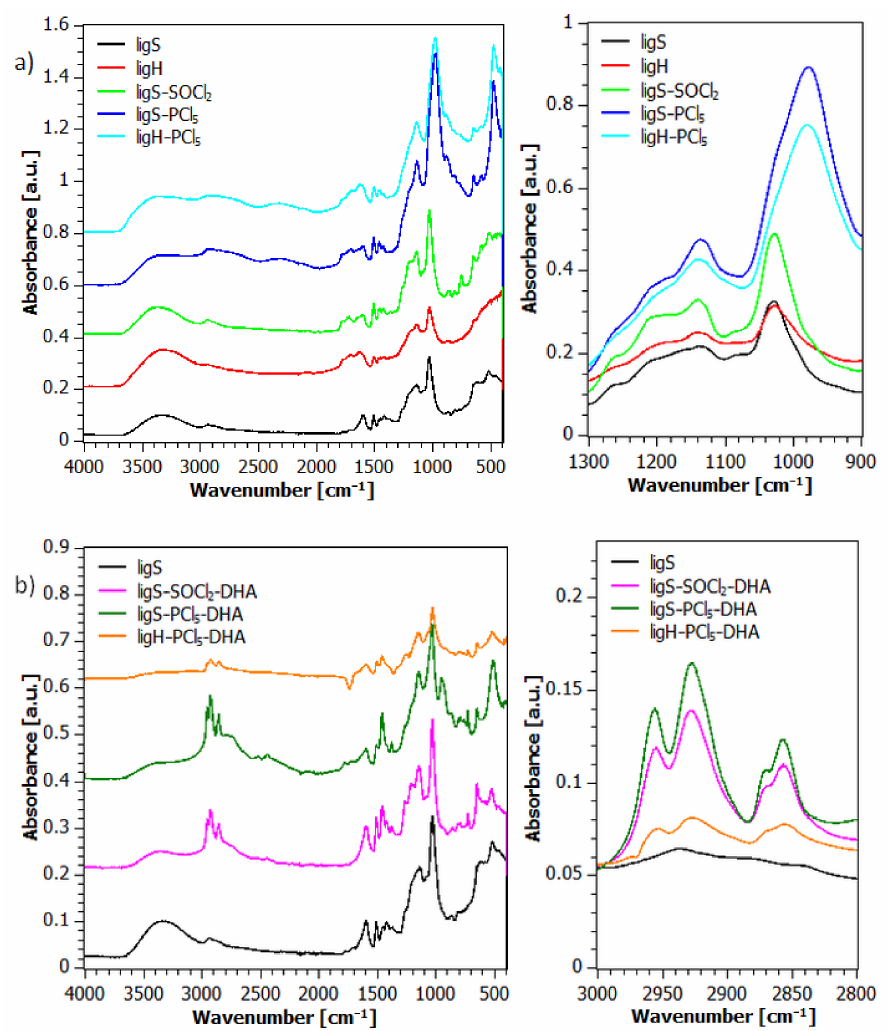
Figure 2. FTIR spectra of the materials obtained after the first ( a ) and the second ( b ) step of the modification